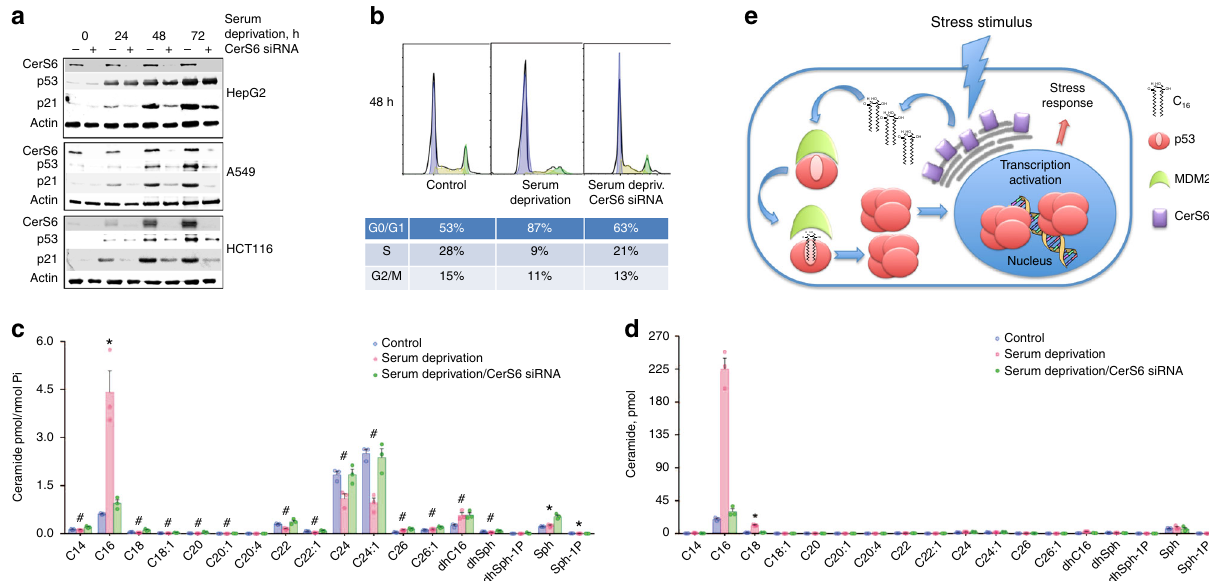
Fig. 6 CerS6-dependent C 16 -ceramide generation mediates stress response to serum starvation. a Serum withdrawal elevates CerS6 in cultured cells with concomitant increase of p53 and p21 while CerS6 siRNA silencing prevents the p53 and p21 accumulation in response to serum withdrawal. b CerS6 siRNA silencing partially rescues G 0 /G 1 cell cycle arrest upon serum starvation. c Serum withdrawal elevates C 16 -ceramide in A549 cells (48 h post-withdrawal); this effect was abrogated upon CerS6 silencing (mean ± SE; n = 3; * P < 0.001; # P < 0.05, ANOVA). d p53 is pulled down in complex with C 16 -ceramide from serum-starved A549 cells but not from serum-starved cells with silenced (siRNA) CerS6 (mean ± SE; n = 3; * P < 0.00001, ANOVA). e Proposed mechanism of p53 regulation by C 16 -ceramide: cellular stress elevates CerS6 in endoplasmic reticulum, leading to generation of C 16 -ceramide (C 16 ); ceramide binds to p53, preventing its interaction with MDM2; this halts the p53 ubiquitination and degradation; resulting accumulation of p53 leads to